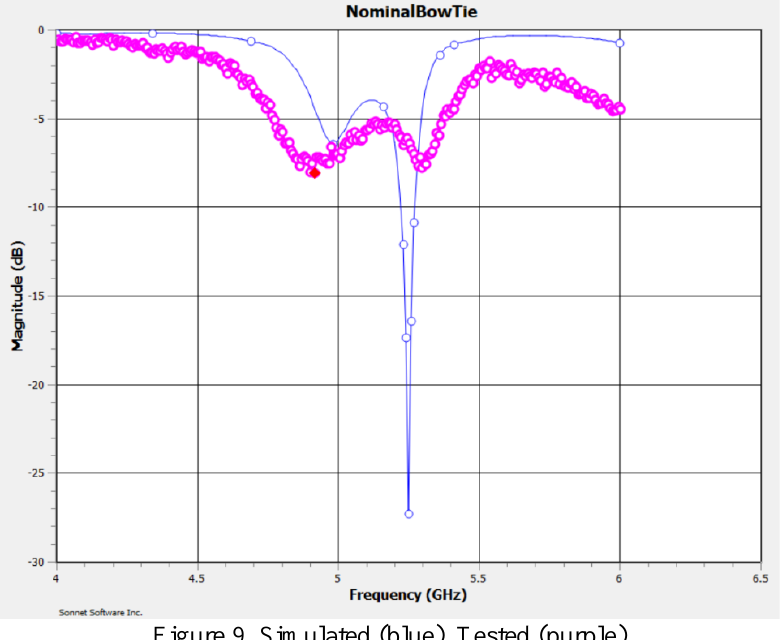
Figure 9. Simulated (blue), Tested (purple)